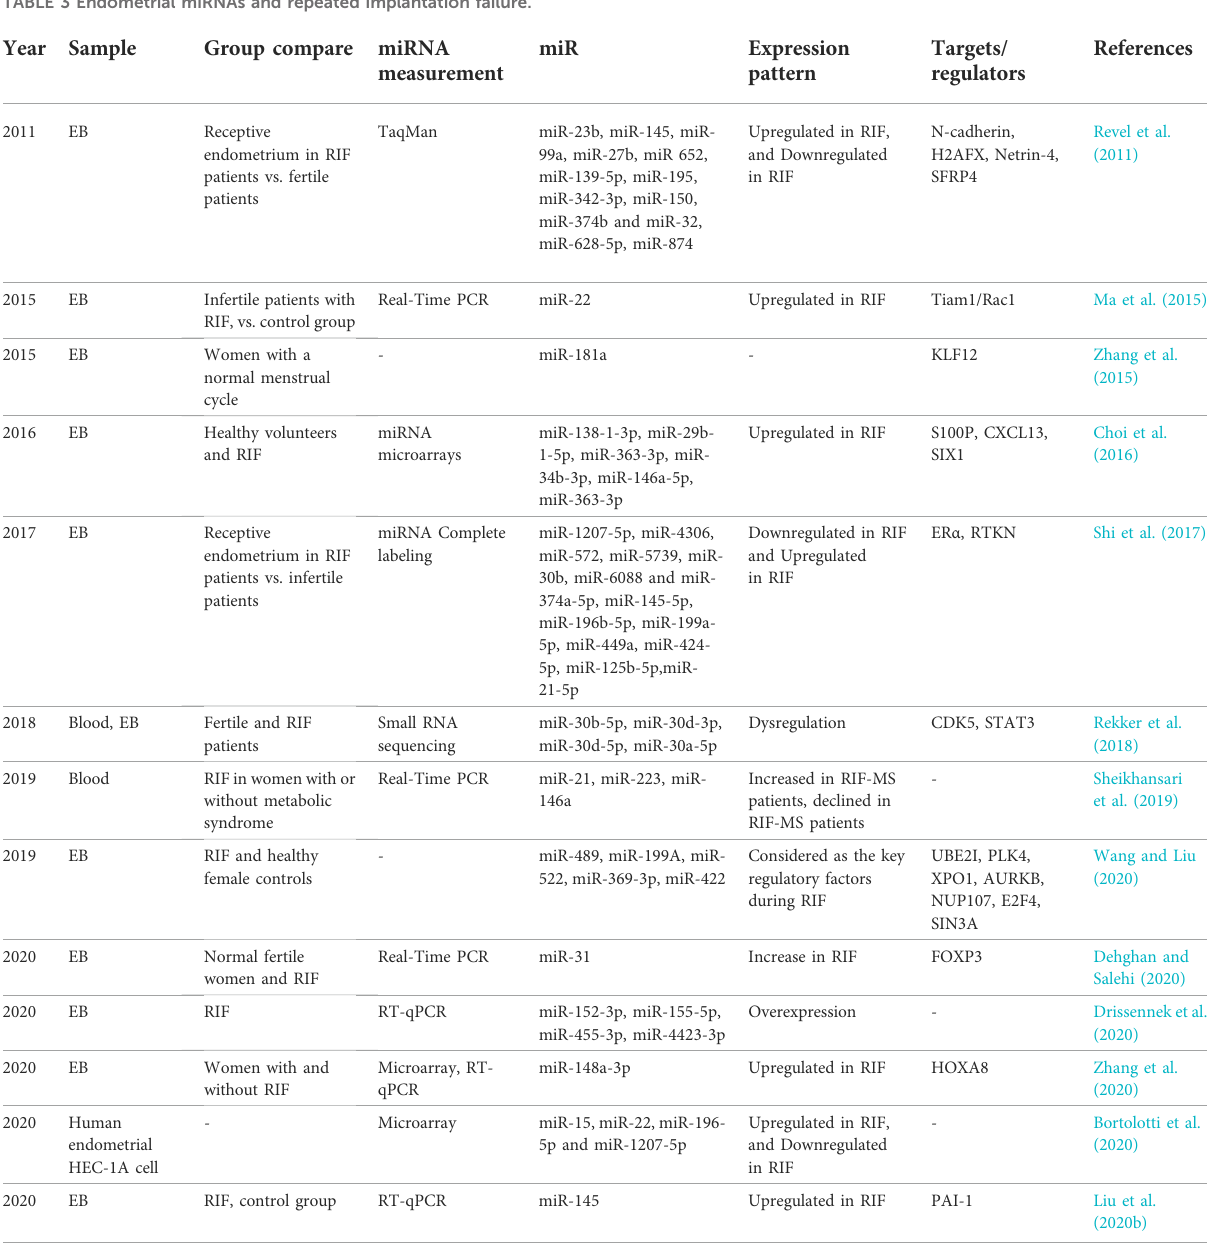
TABLE 3 Endometrial miRNAs and repeated implantation